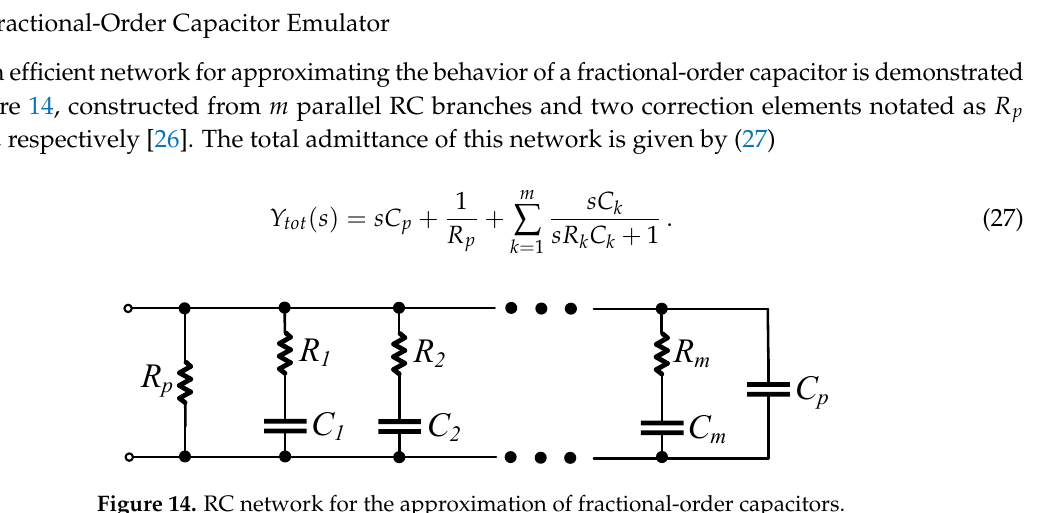
Figure 14. RC network for the approximation of fractional-order